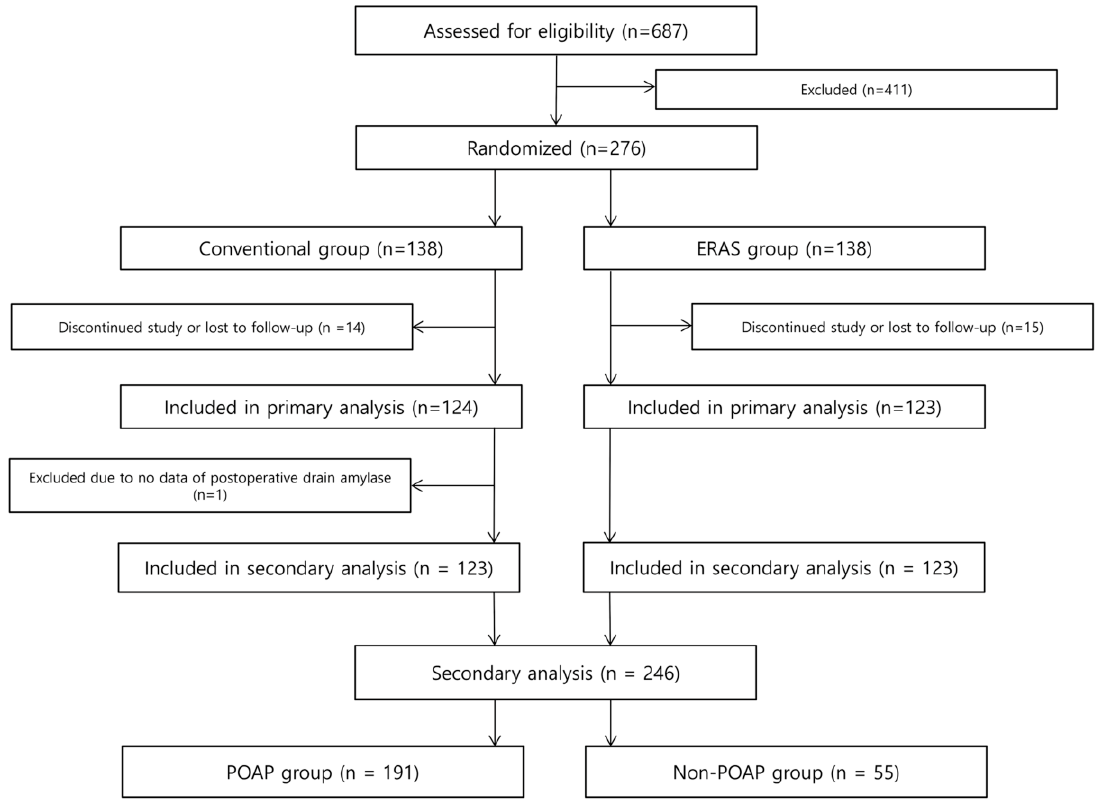
Figure 1. Flow diagram showing the inclusion and exclusion criteria of original and secondary analysis.